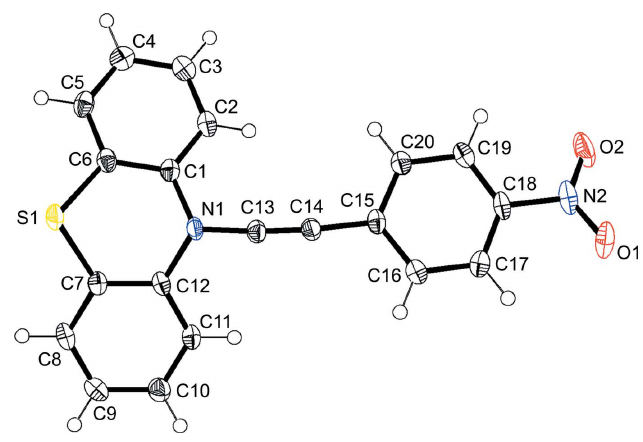
Figure 1 ORTEP view of the title compound with the atom-numbering scheme. Displacement ellipsoids are drawn at the 50% probability level and H atoms are shown as small spheres of arbitrary